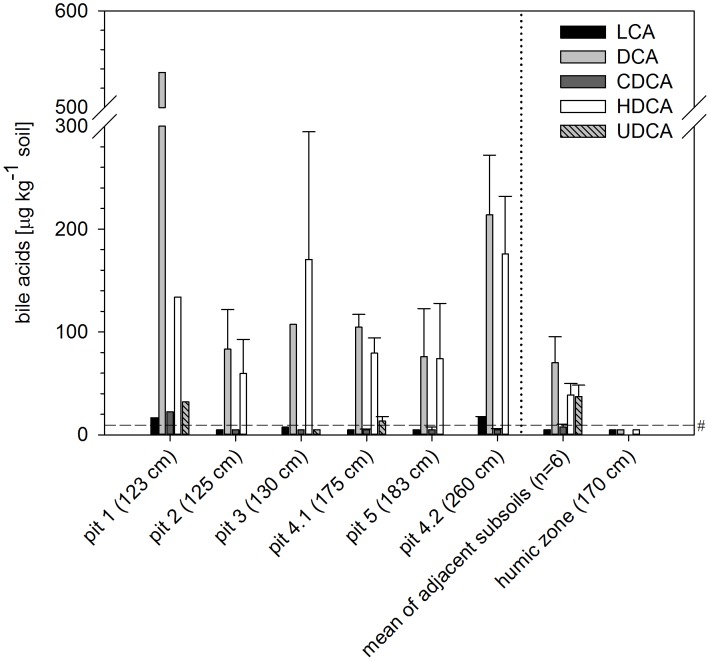
Bile acid contents of the selected pit fillings, the adjacent subsoils and the Early Weichselian humic zone at various soil depths as indicated in parentheses.The dashed line marks the limit of quantification. LCA = lithocholic acid, DCA = deoxycholic acid, CDCA = chenodeoxycholic acid, HDCA = hyodeoxycholic acid, UDCA = ursodeoxycholic acid. Error bars represent the standard deviation of laboratory replicates, whereas error bars of the mean of adjacent subsoils show the standard error of the six averaged adjacent subsoils.